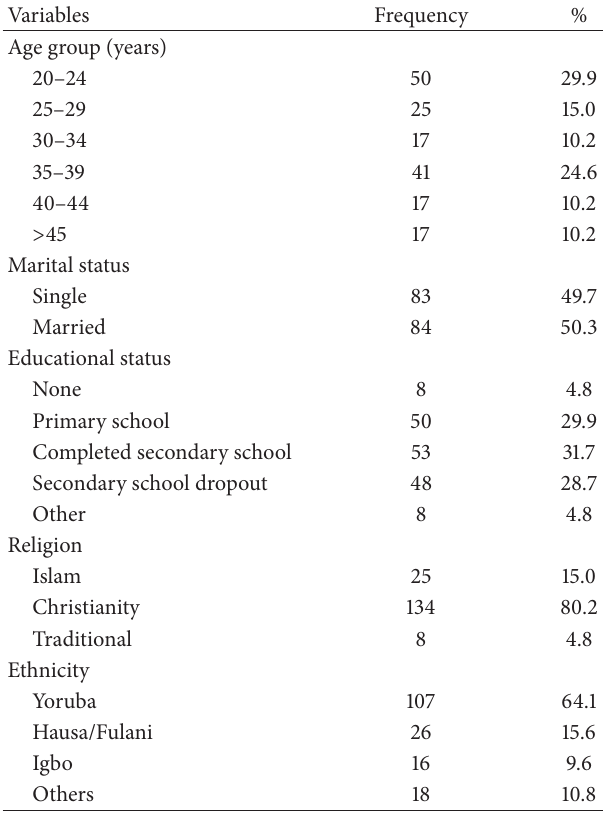
Table 1: Sociodemographic characteristics of